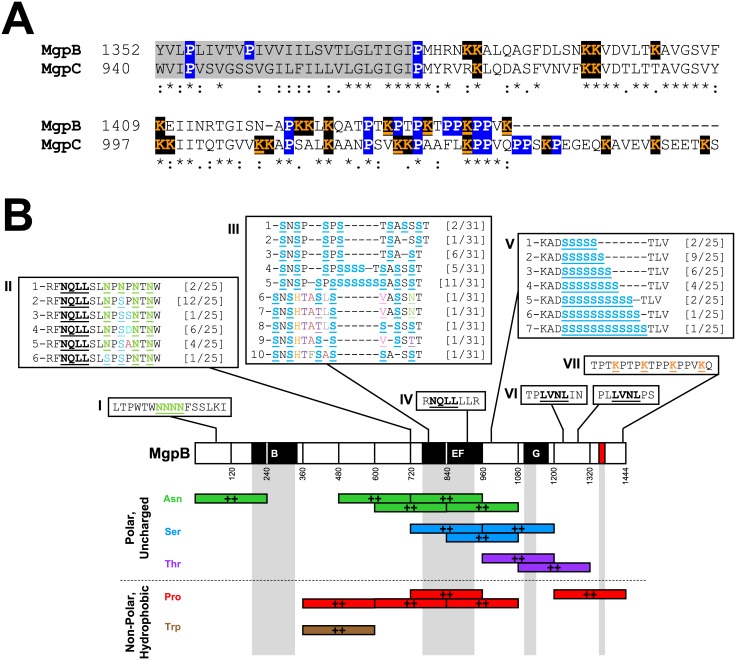
Unique Features of MgpB Including C-terminal Homology to MgpC, Periodic Repeats, and Overrepresented Amino Acids are Illustrated using in silico Analyses.(A) The distal C-termini of MgpB and MgpC are homologous, share periodic lysine repeats (every fourth or seventh amino acid; orange underline) and are proline-rich (blue). Remaining lysine residues not included within the periodic repeat are in orange/black. BLAST alignment of the predicted transmembrane domains (gray) and beyond for aa 1,352–1,443 and 940–1,053 of MgpB and MgpC, respectively, demonstrate the cytoplasmic domain of MgpB has significant homology to aa 940–1,032 of MgpC with an e-value of 1e-21. (B) Schematic diagram of MgpB showing amino acid repeat sequences and periodicity including (boxes): (I) asparagine repeats at aa 71 (green, underlined), (II) alternating asparagine repeats at aa 733 (green, underlined), (III) alternating serine repeats at aa 778 (blue, underlined), (IV) “NQLL” motif found twice at aa 727 and 908 (bold, dashed underline in boxes II and IV), (V) serine repeats at aa 989 (blue, underlined), (VI) “LVNL” sequence found at aa 1,233 and 1,288 (double underline), and (VII) lysine residues repeated every fourth amino acid in the threonine/proline-rich distal conserved C-terminus, aa 1,431 (orange, underlined; also shown in panel B). Sequences in boxes I, IV, VI, and VII were 100% conserved in all strains while sequences containing alternating asparagine and serine repeats varied, indicated by numbered sequences within boxes II, III, and V. Sequence 1 corresponds to G37 and the number of variants expressing each unique sequence is shown to the right in brackets (see S2 Fig for a complete alignment). Shown below is an illustration of the overrepresented amino acids within overlapping ~240 aa segments of MgpB, determined using the SAPS B. subtilis reference set; overrepresented residues (99% quantile point) are indicated by “++”. The complete SAPS analysis including underrepresented amino acids and comparisons to other reference sets (E. coli and a random sample of proteins) can be found in S4 Table.